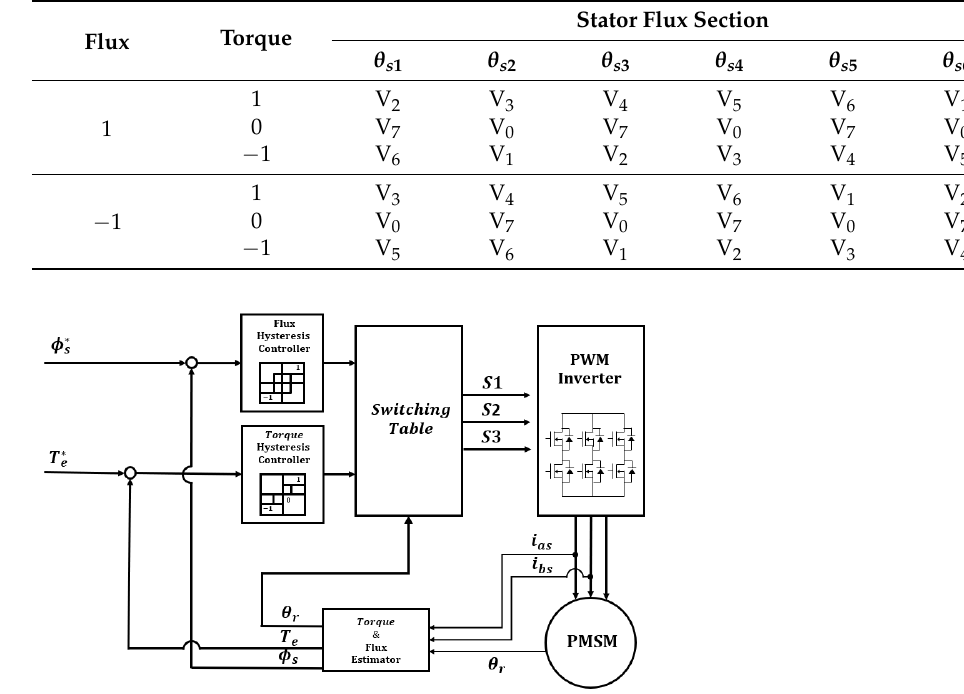
Figure 2. Stator flux trajectory according to the voltage vector command under conventional DTC using LUT (lookup table). Table 1. LUT (lookup table) used for conventional DTC control. Flux Torque